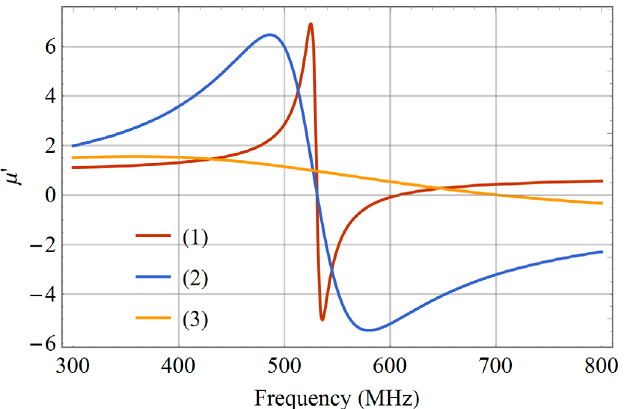
Fig. 5. Phase on re fl ection of a patch array vs frequency: (1) No negative inductance, C g = C gl = 12.8pF (2) L neg = (cid:2) 32.2nH, C g = C g0 = 0.25pF, R NF 0 V (3) L neg = (cid:2) 32.2nH, C g = C g0 = 0.25pF,